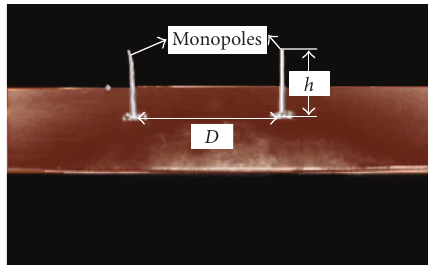
Figure 2: A two-monopole